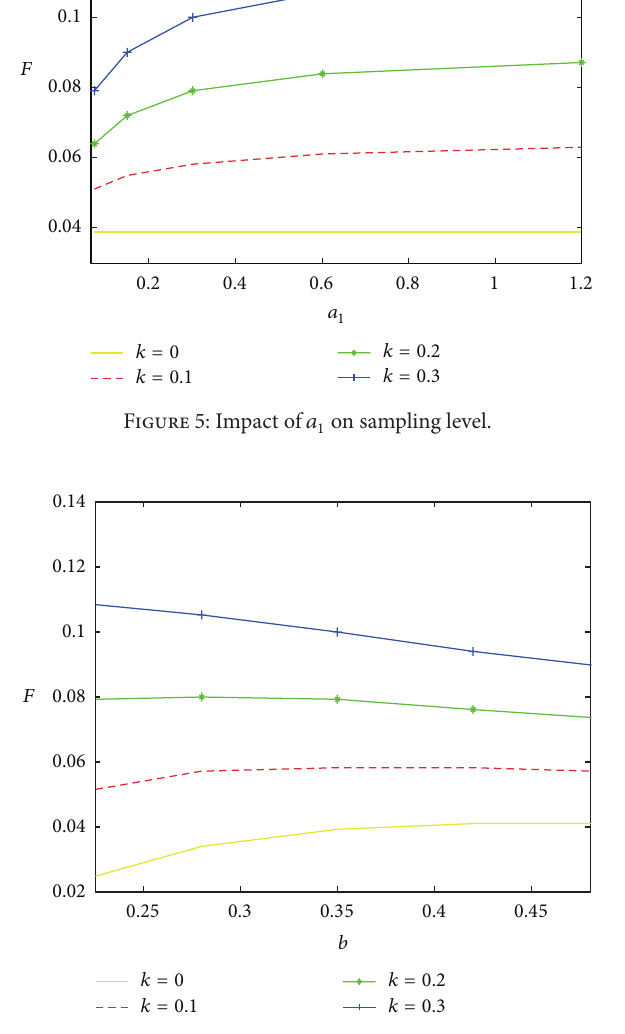
Figure 6: Impact of 𝑏 on sampling level.